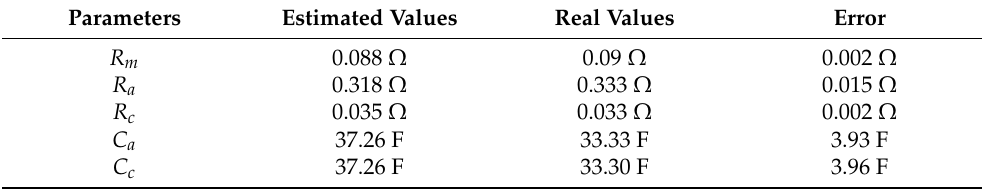
Table 3. Comparison between the estimated and real values of the PEM electrolyzer emulator.